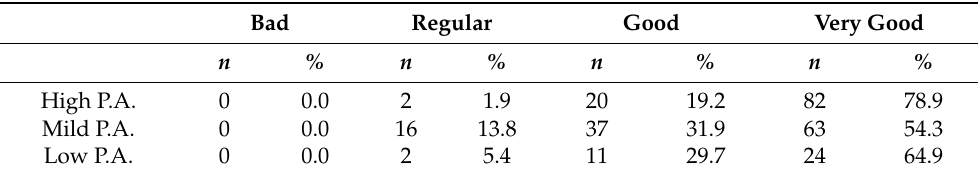
Table 5. Frequencies of the functional autonomy subscale (CUBRECAVI) according to their level of physical activity. Bad Regular Good Very Good n % n % n % n % High P.A. 0 0.0 2 Mild P.A. 0